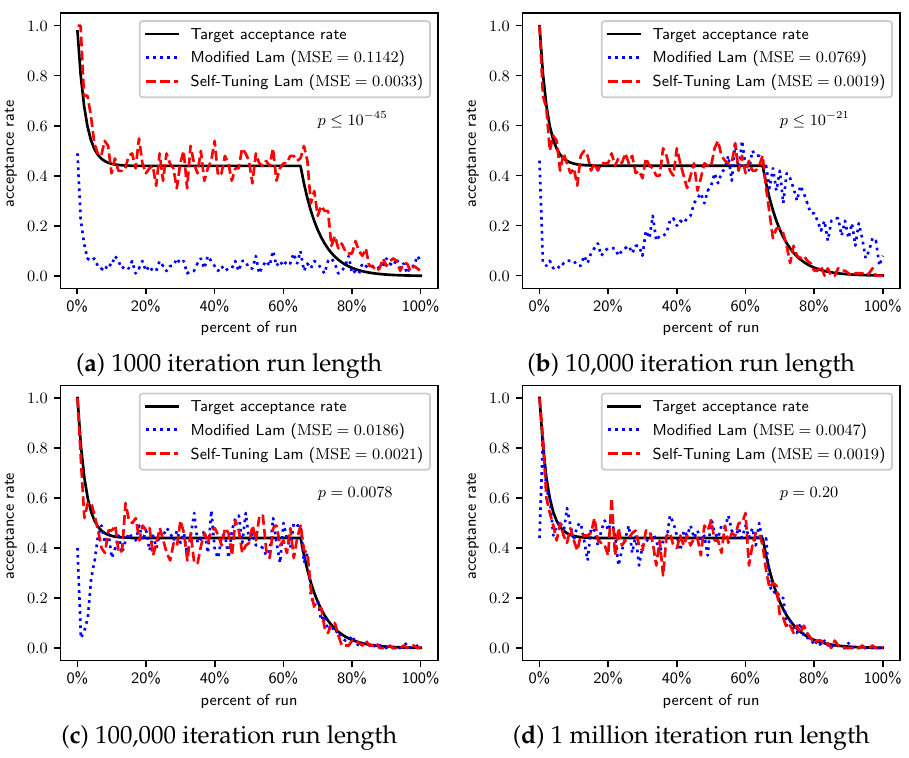
Figure 15. Minimize f 2,1000 ( x ) : Self-Tuning Lam, Modified Lam, and target acceptance rates for ( a ) 1000 iterations, ( b ) 10,000 iterations, ( c ) 100,000 iterations, and ( d ) 1 million iterations.